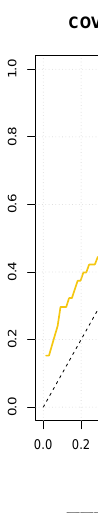
Figure 6. TTT plot for the COVID-19